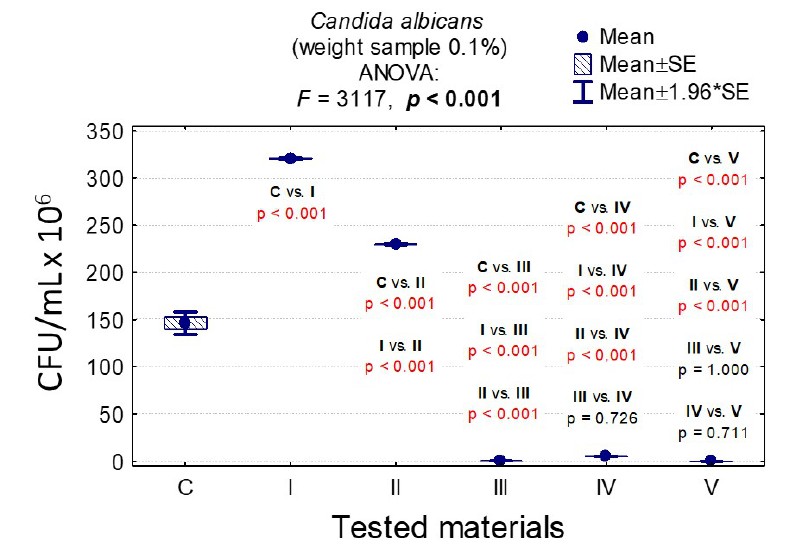
Figure 6. Average Colony-Forming Units (CFU) / mL values and standard deviation (M ± SD) for Candida albicans after contact with tested materials (C—control group, I—nHAp, II—Cu 2 + -doped nHAp, III—nHAp with the addition of ozonated olive oil, IV—nHAp doped with Cu 2 + and loaded with ozonated olive oil, V—ozonated olive oil) for weights of 0.1% and results of the analysis of variance (ANOVA) and multiple comparisons by a post-hoc test. Incubation took 24 h.